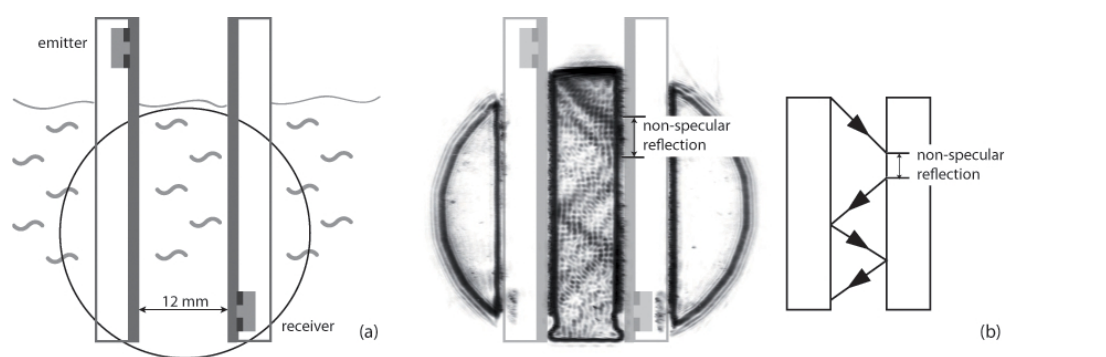
Figure 12. (a) Measurement setup for the Schlieren visualization of the inverse mode conversion process. (b) Schlieren image of the sound wave propagation within the liquid-filled gap of the measurement